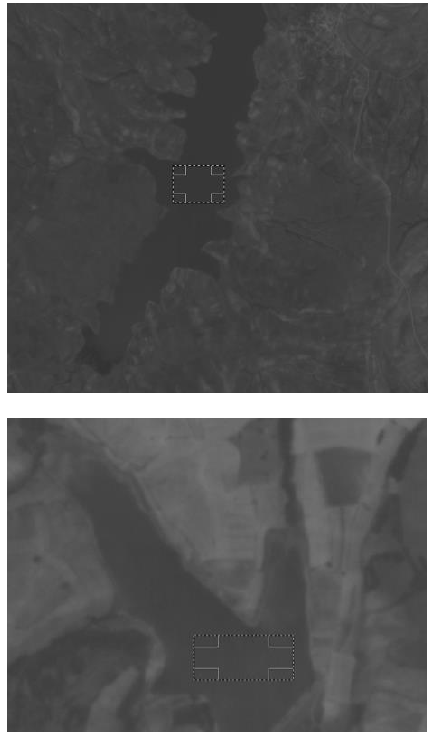
Figure 4. Two of the lakes with RASAT L1 image patches (white rectangles with dotted lines) used for the noise